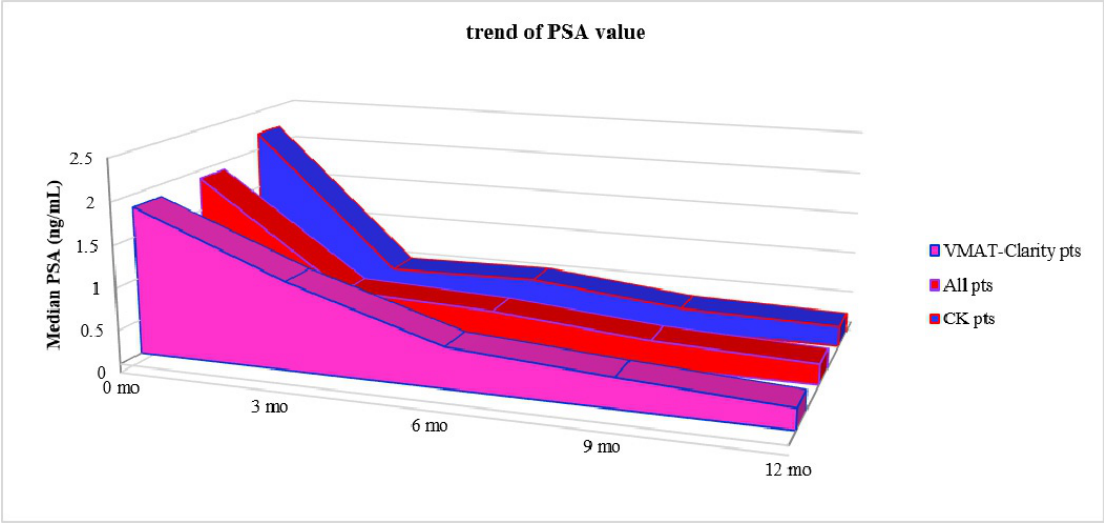
Figure 1. Median PSA in all patients, CK and Clarity ®